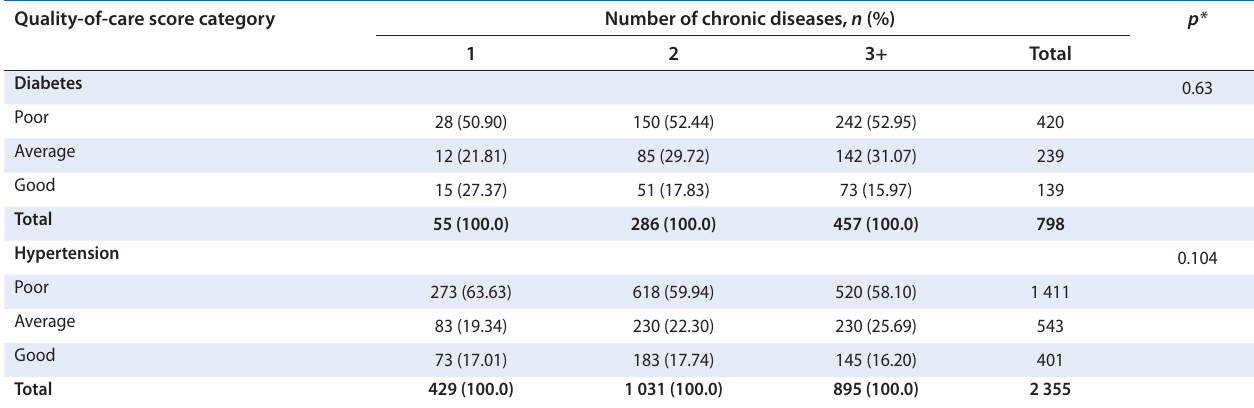
Table 5: Quality-of-care scores for diabetes and hypertension for a different number of co-morbidities Quality-of-care score